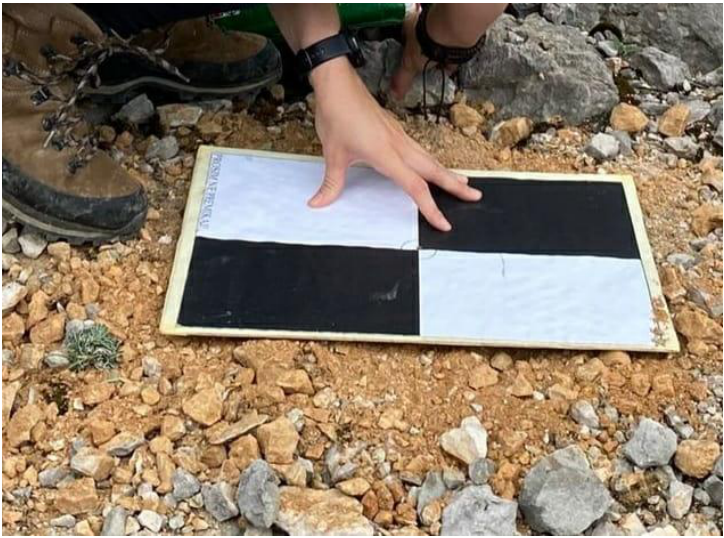
Figure 4. Example of verification point (VP)/ground control point (GCP) target set out in the